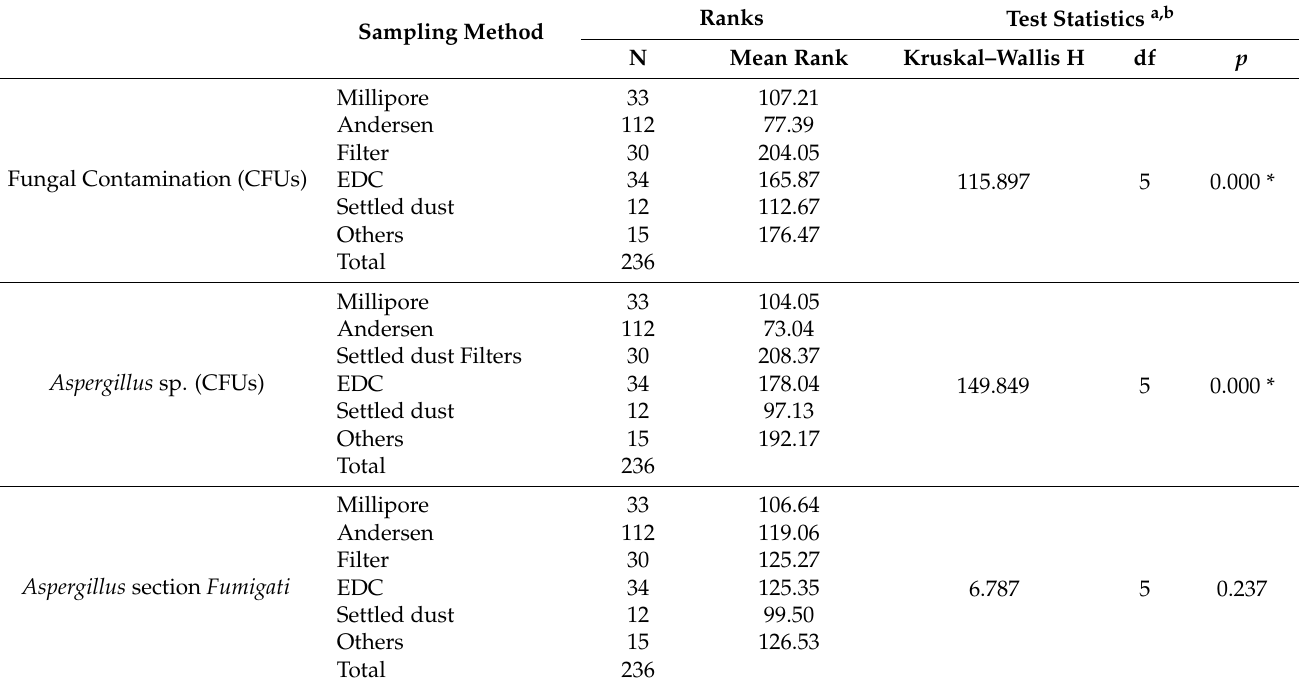
Table 5. Comparison of fungal contamination, Aspergillus sp. and Aspergillus section Fumigati between sampling methods. Kruskal–Wallis test.